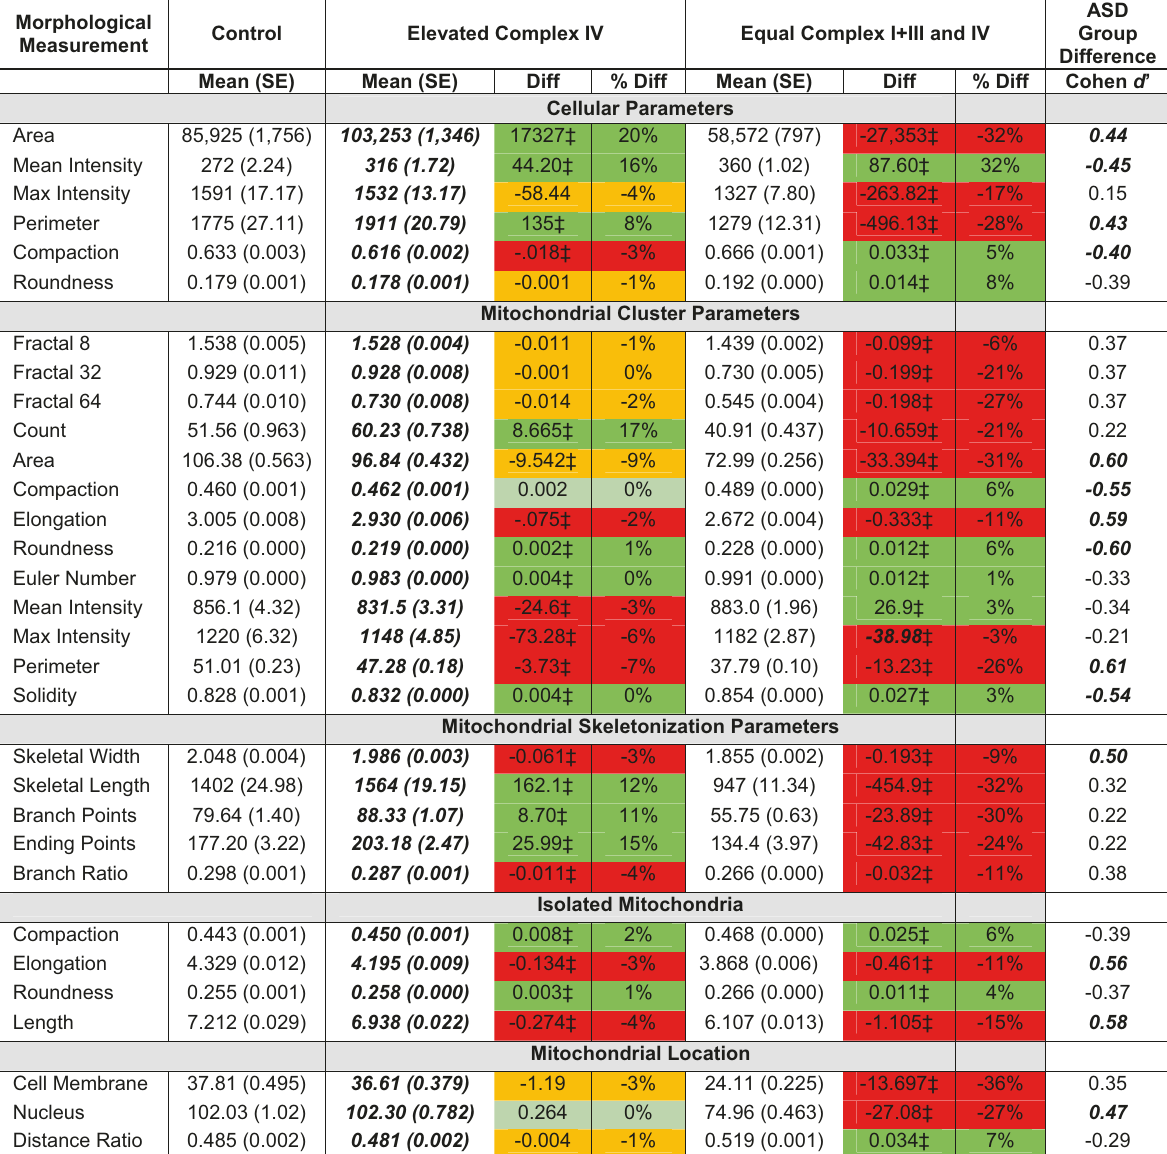
Table 6. Means (SE = Standard Error) of morphological measurements for three groups, control fi broblasts, ASD fi broblasts with elevated Complex IV activity relative to Complex I + III and ASD fi broblasts with relatively equal Complex IV and I + III activities. Morphological